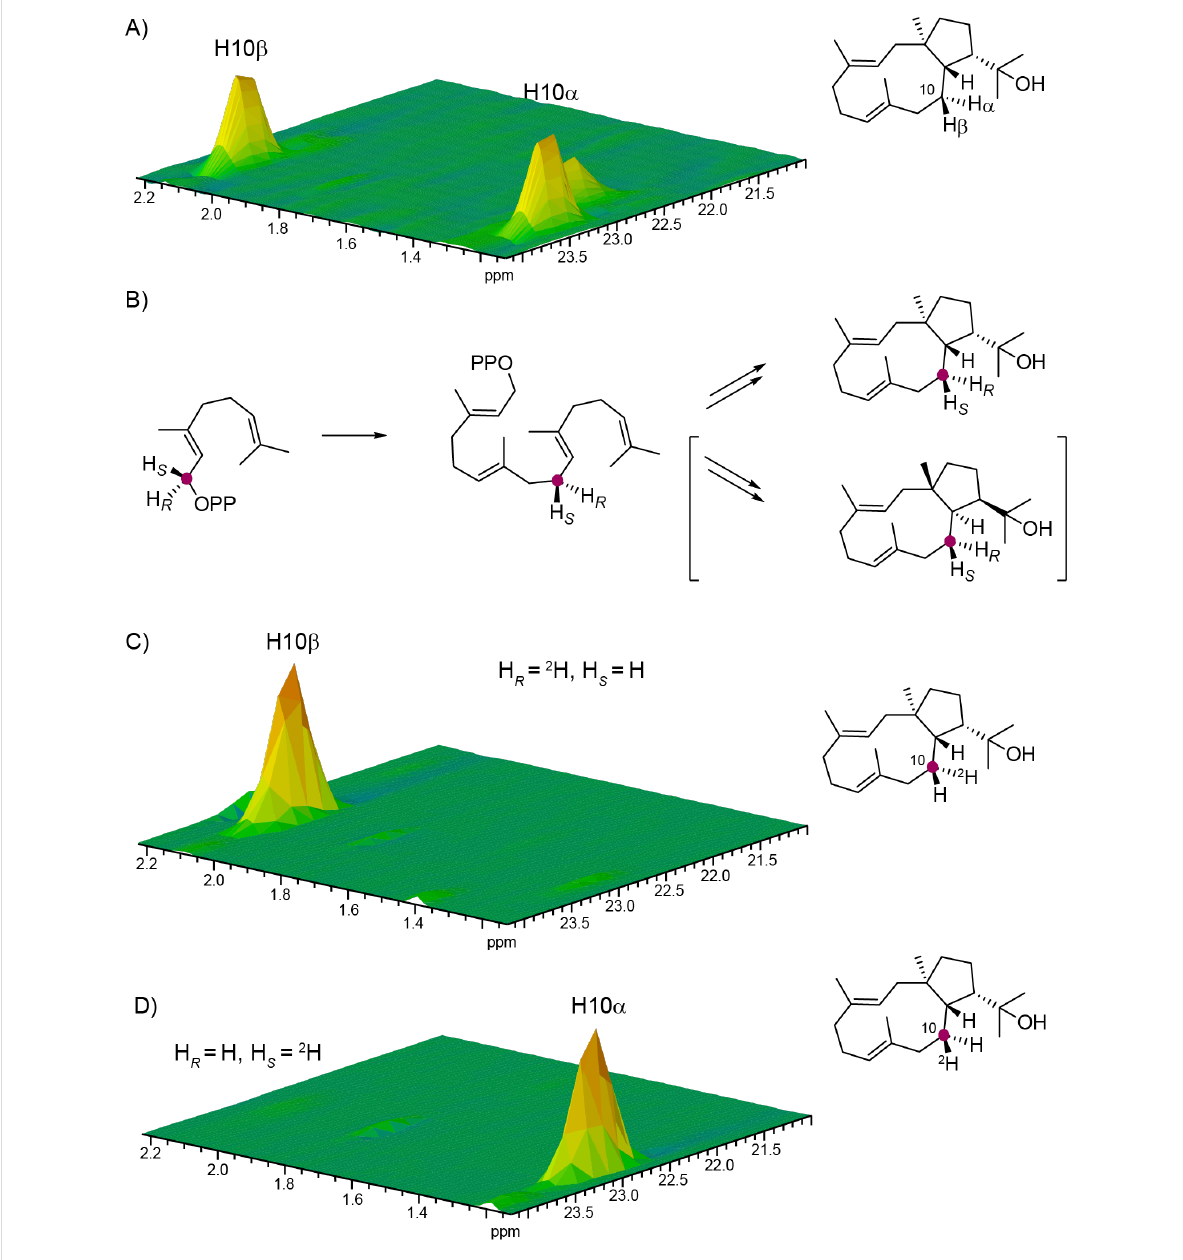
Figure 3: Determination of the absolute configuration of 3 . (A) Partial HSQC spectrum of unlabelled 3 showing the region for C10, (B) elongation of GPP with IPP to GGPP and cyclisation to the two possible enantiomers of 3 , (C) partial HSQC spectrum of the product obtained from ( R )-(1- 13 C,1- 2 H)GPP, and (D) partial HSQC spectrum of the product obtained from ( S )-(1- 13 C,1- 2 H)GPP. Purple dots indicate 13 C-labelled